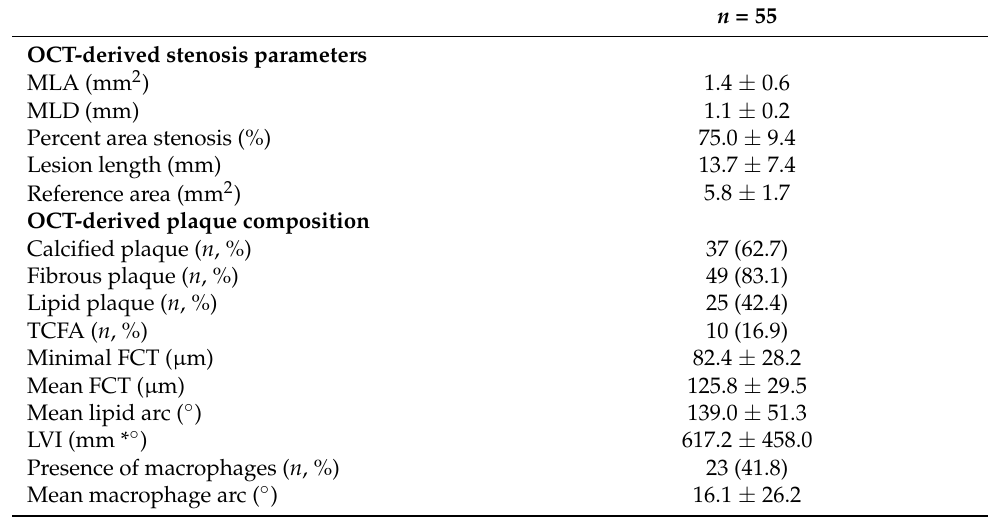
Table 2. OCT-derived lesion characteristics. Abbreviations: MLA = minimal lumen area, MLD = min- volume